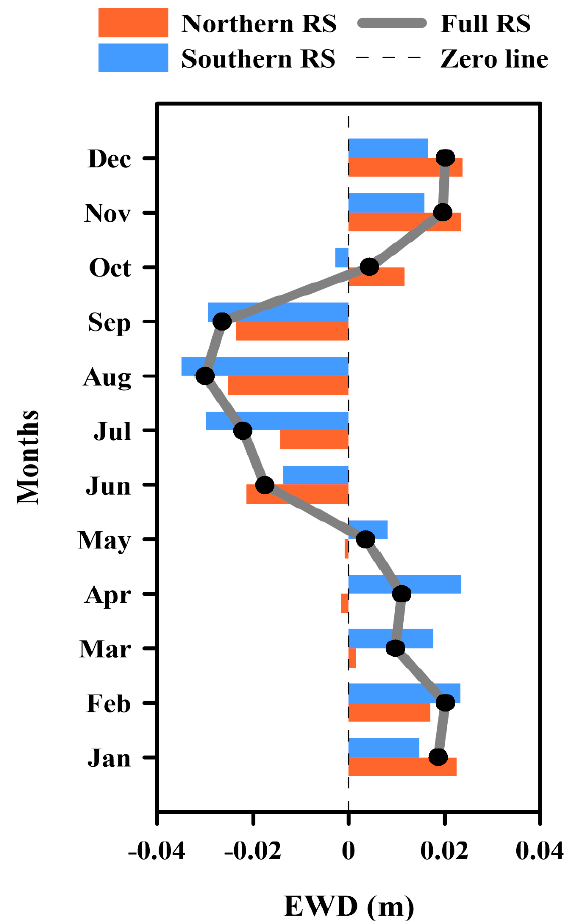
Figure 8. The EW difference pattern for the northern Red Sea (orange), the southern Red Sea (blue), Figure 8. The EW di ff erence pattern for the northern Red Sea (orange), the southern Red Sea (blue), and the whole Red Sea basin (grey). and the whole Red Sea basin